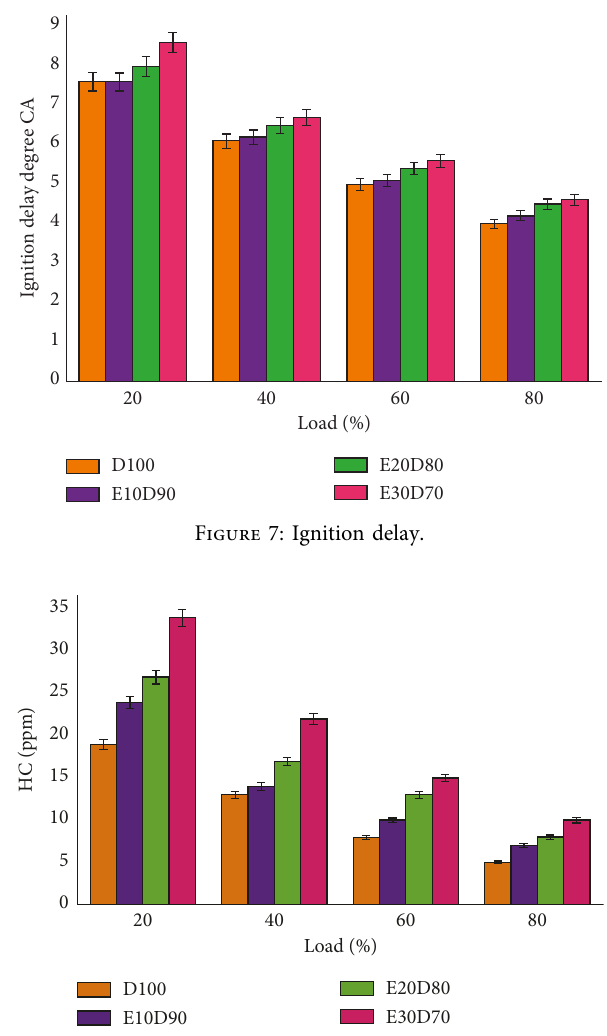
Figure 8: Variation in HC with